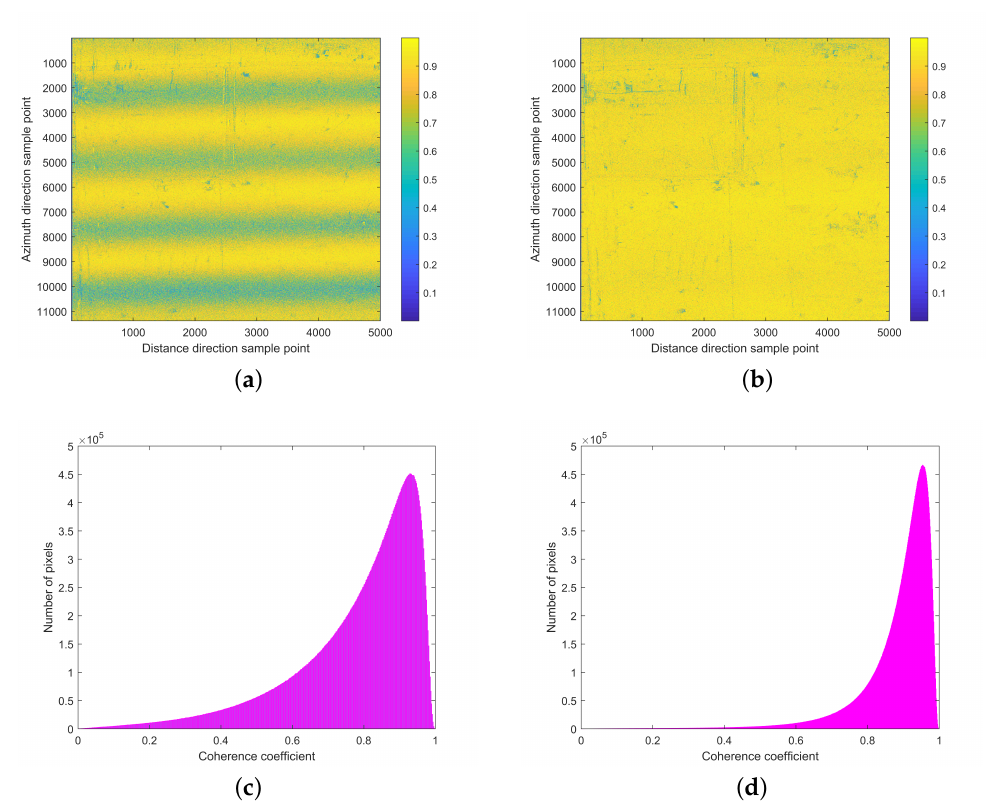
Figure 18. The comparison results. ( a ) The comparison method coherence coefficient diagram; ( b ) the proposed method coherence coefficient diagram; ( c ) the comparison method coherence coefficient statistical histogram; ( d ) the proposed method coherence coefficient statistical histogram.